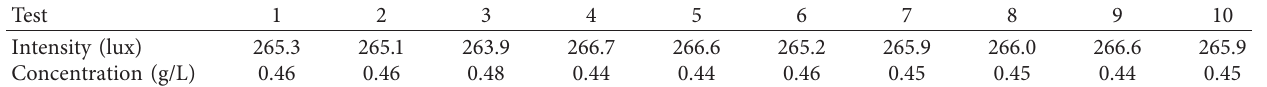
Table 3: The intensities and concentrations measured by smartphone.